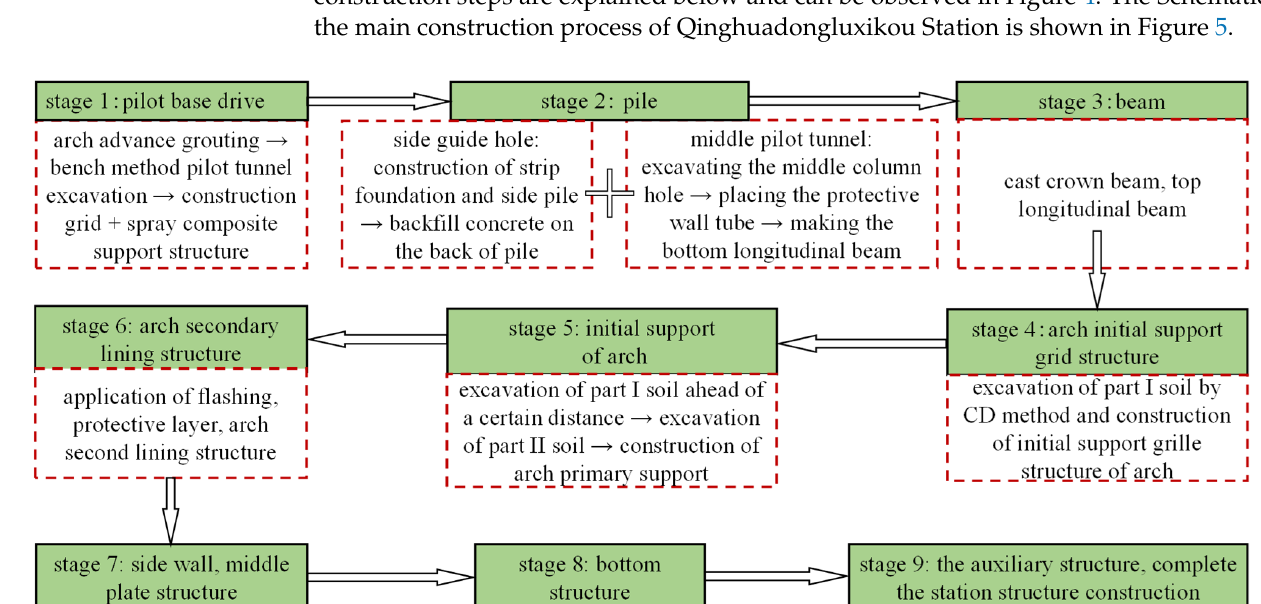
Table 1. Soil properties.